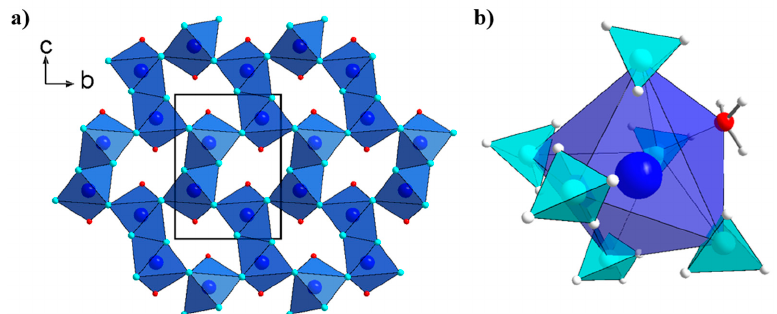
Figure 5. ( a ) Crystal structure of Ba(BH 4 ) 2 · NH 3 (space group P 2 1 2 1 2 1 ). Hydrogen is omitted for clarity. ( b ) Local coordination geometry of Ba 2+ with BH 4- and NH 3 in a square-face monocapped trigonal prismatic geometry. Color scheme: Ba (blue), B (turquoise), N (red), H (white).